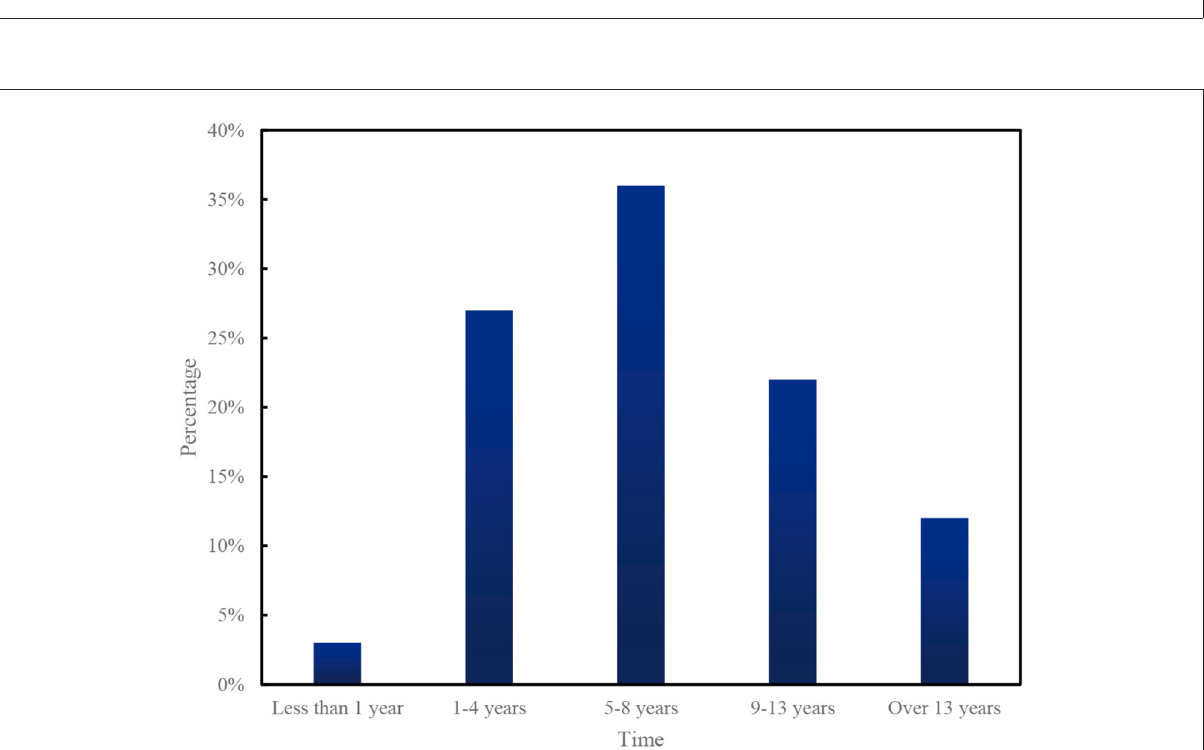
FIGURE10 Legend of the percentage of physical training years for persons with physical